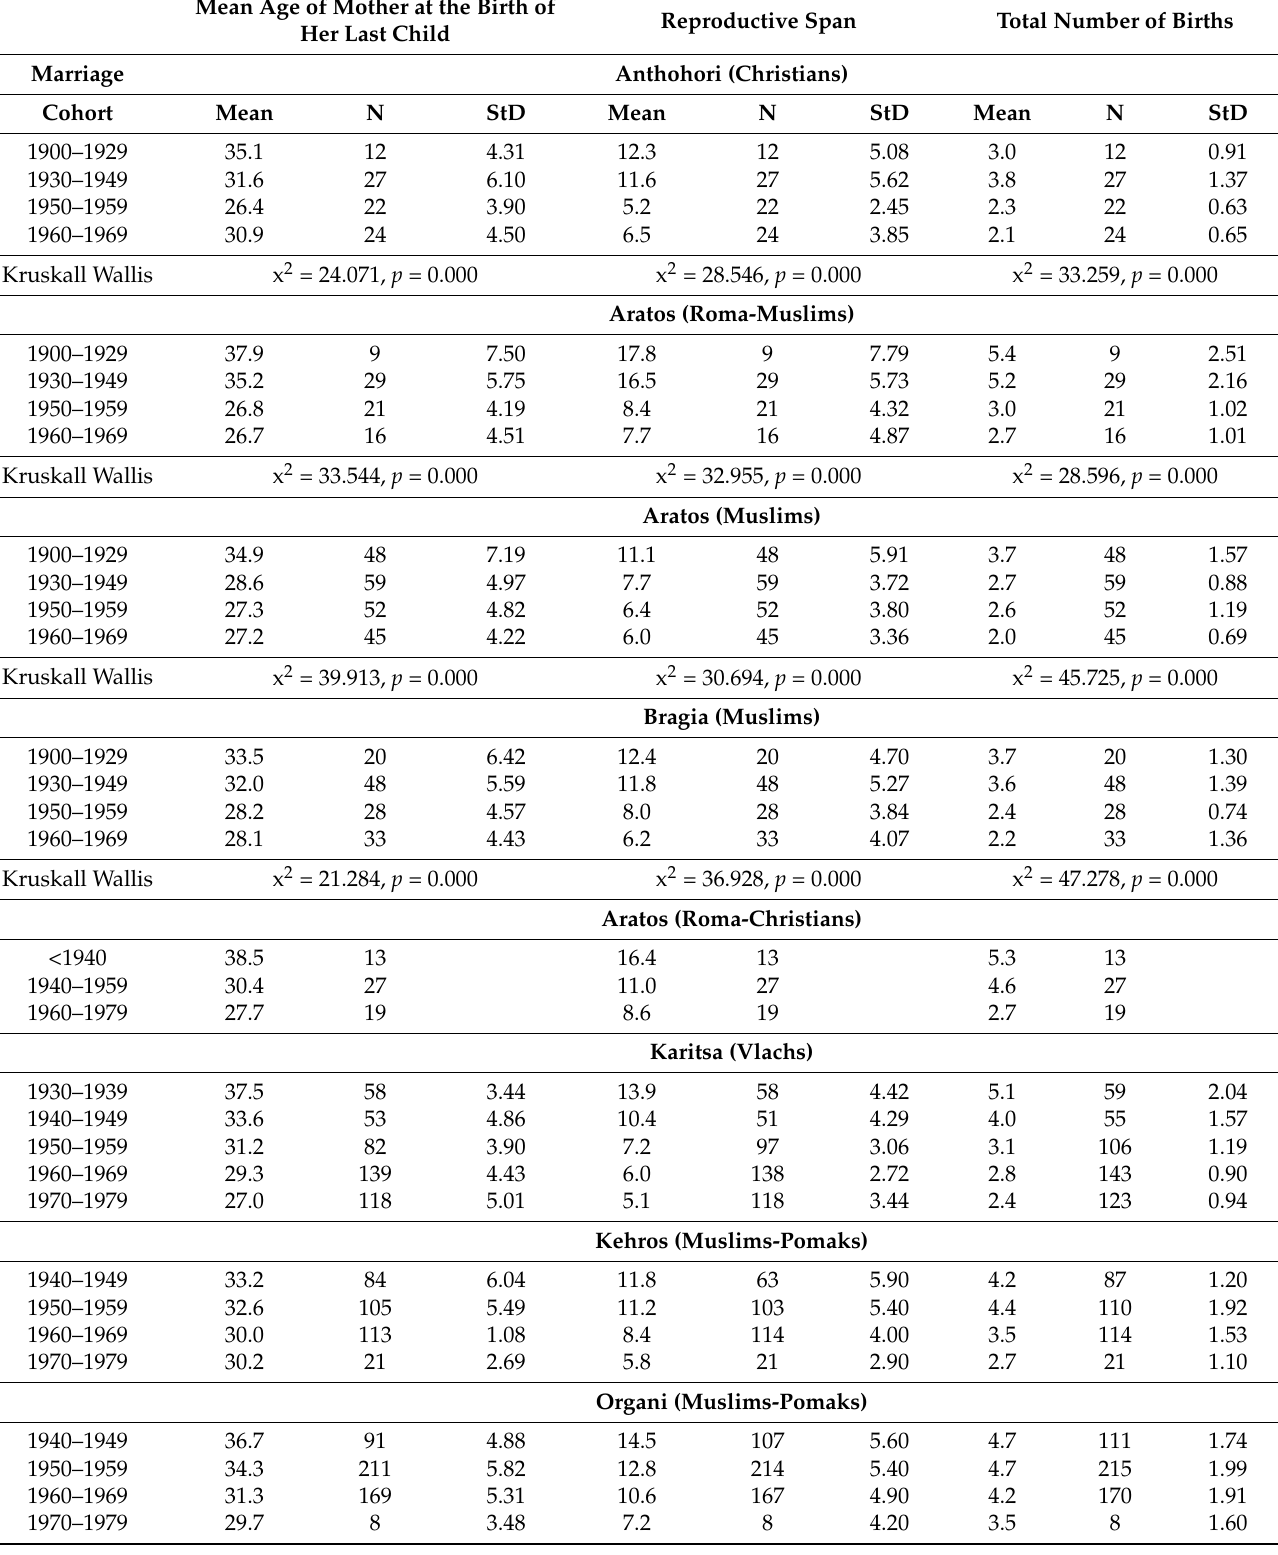
Table 3. Mean age of mother at the birth of her last child, reproductive span and children ever born per marriage (Completed families). First marriage of the